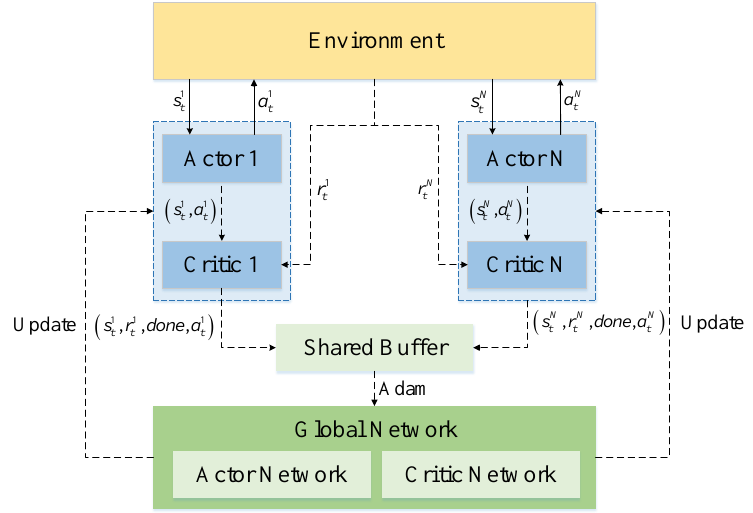
Figure 6. MAPPO’s parameter